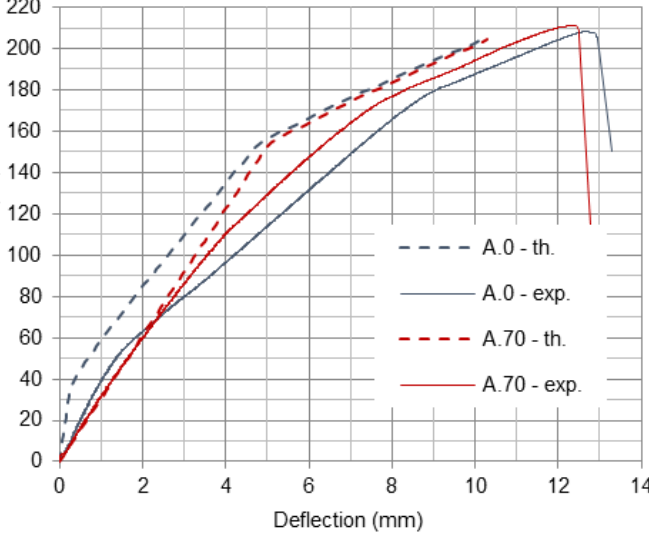
Figure 11. Comparison of theoretical and experimental load-deflection plots for A.0 and A.70